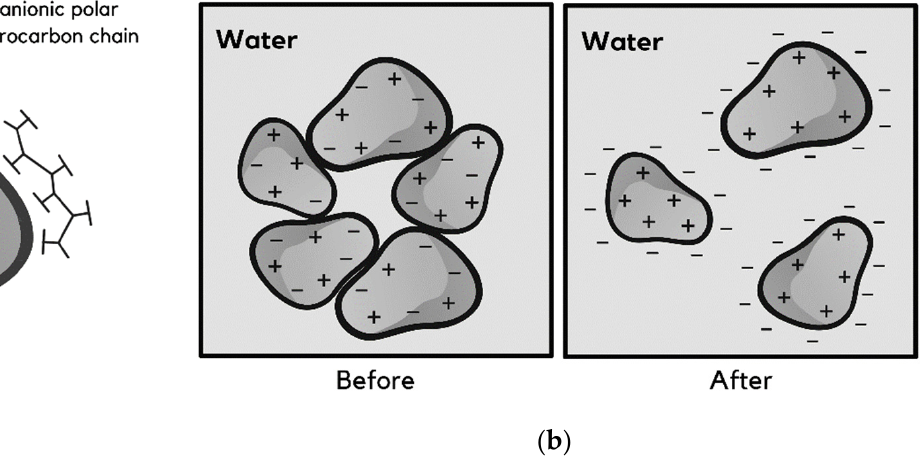
Figure 1. ( a ) Adsorption of the polar chains of a surfactant admixture on the surface of the cement particle; ( b ) Floc formation by cement particles before the incorporation of a surfactant admixture, and dispersion of flocs after the incorporation (adapted from Mehta and Monteiro [41]).